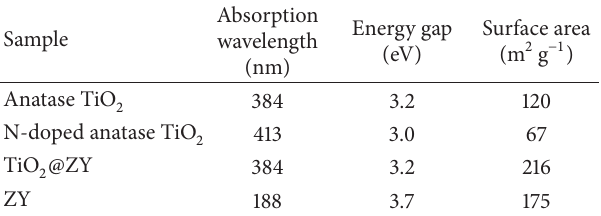
Table 1: Values of absorption wavelength, energy gap, and BET surface area determined for each